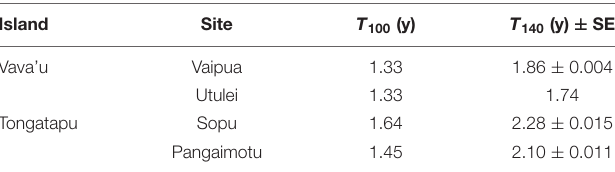
TABLE 3 | Age of “young” Pteria penguin at a minimum pearl-production size of 100 and 140 mm dorso-ventral height ( T 100 and T 140 , respectively) at experimental